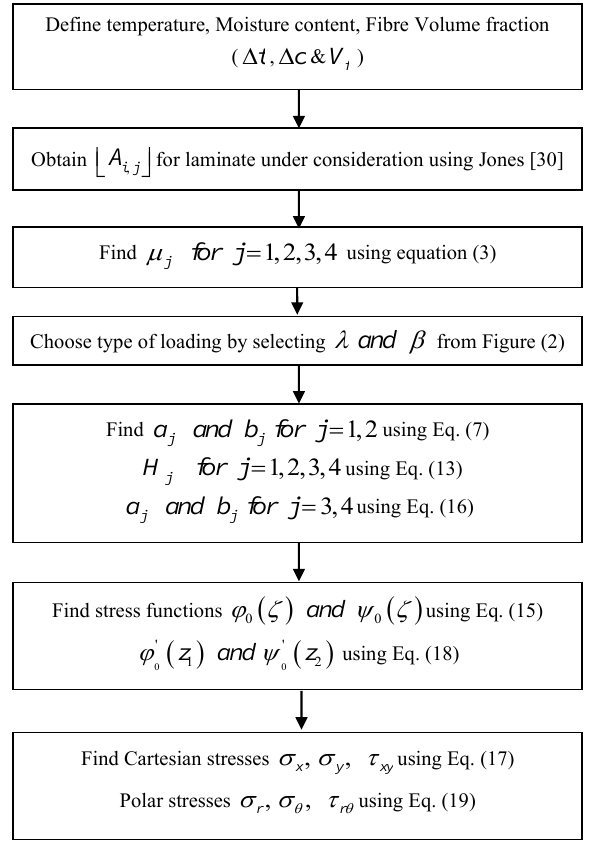
Figure 4: Flow chart indicating steps in finding stresses around elliptical